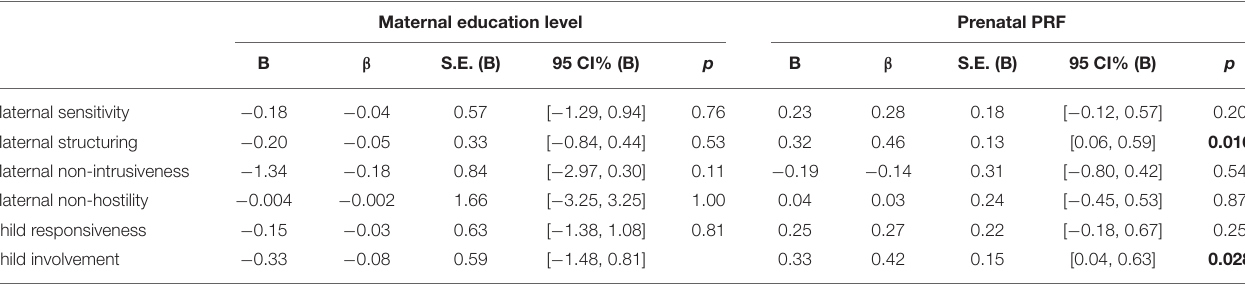
TABLE 5 | Associations between maternal prenatal PRF and maternal and child EA at 4